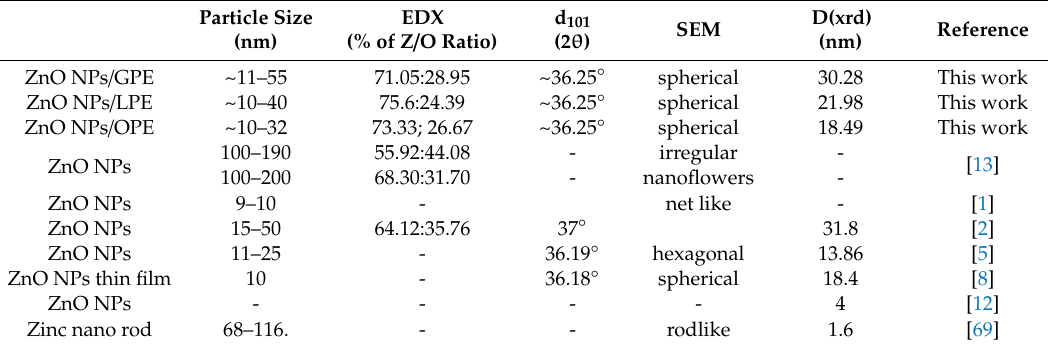
Table 5. Comparative morphological study of ZnO NPs / CPE with other literature reports.